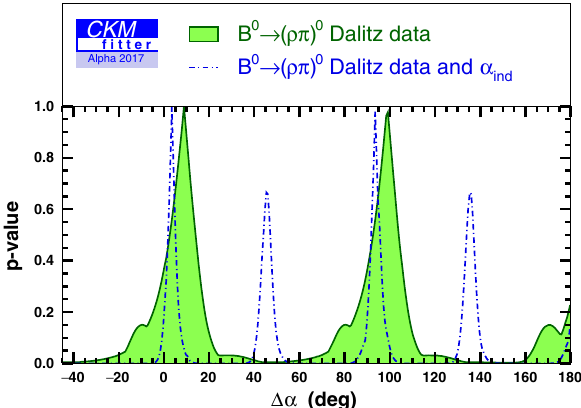
Fig. 35 One-dimensional scan of Δα = (α − α eff ) from the isospin analysis of B 0 → (ρπ) 0 Dalitz data. The dashed curve includes the indirect determination α ind as additional constraint